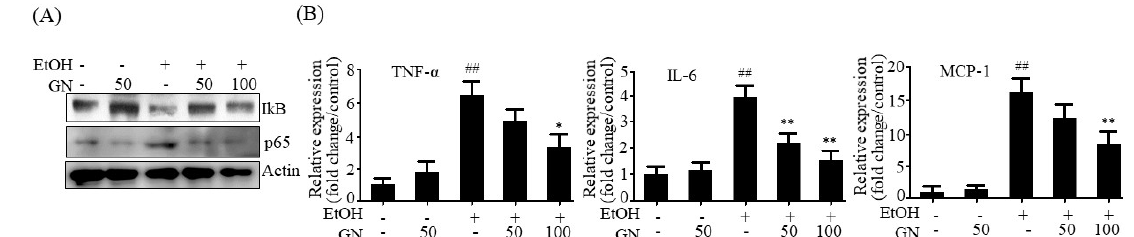
Figure 8. Gomisin N decreases ethanol-induced inflammation gene expression in HepG2 cells. HepG2 cells were treated with 50 mM ethanol in the presence or absence of GN (50 or 100 μM) for 24 h. ( A ) Western blot analysis of IκB and NF-κB p65. ( B ) qPCR analysis of hTNF-α, hIL-6, and hMCP-1. Values are the mean ± SD of triplicate experiments. ## p < 0.01 vs. untreated control, * p < 0.05, ** p < 0.01 vs. ethanol-treated group.